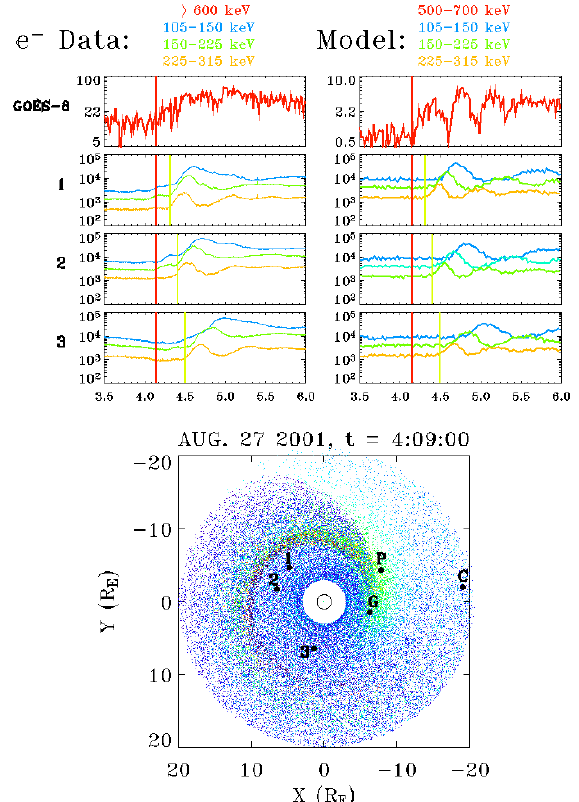
Fig. 1. Flux measurements from GOES-8 (G) and 3 LANL satellites (1, 2 and 3) on 27 August 2001 (upper left) and simulated differ- ential fluxes at the corresponding virtual satellite locations (upper right). On the lower panel, a snapshot of the locations of individual simulated particles at 04:09 UT and satellite locations at that time is presented.